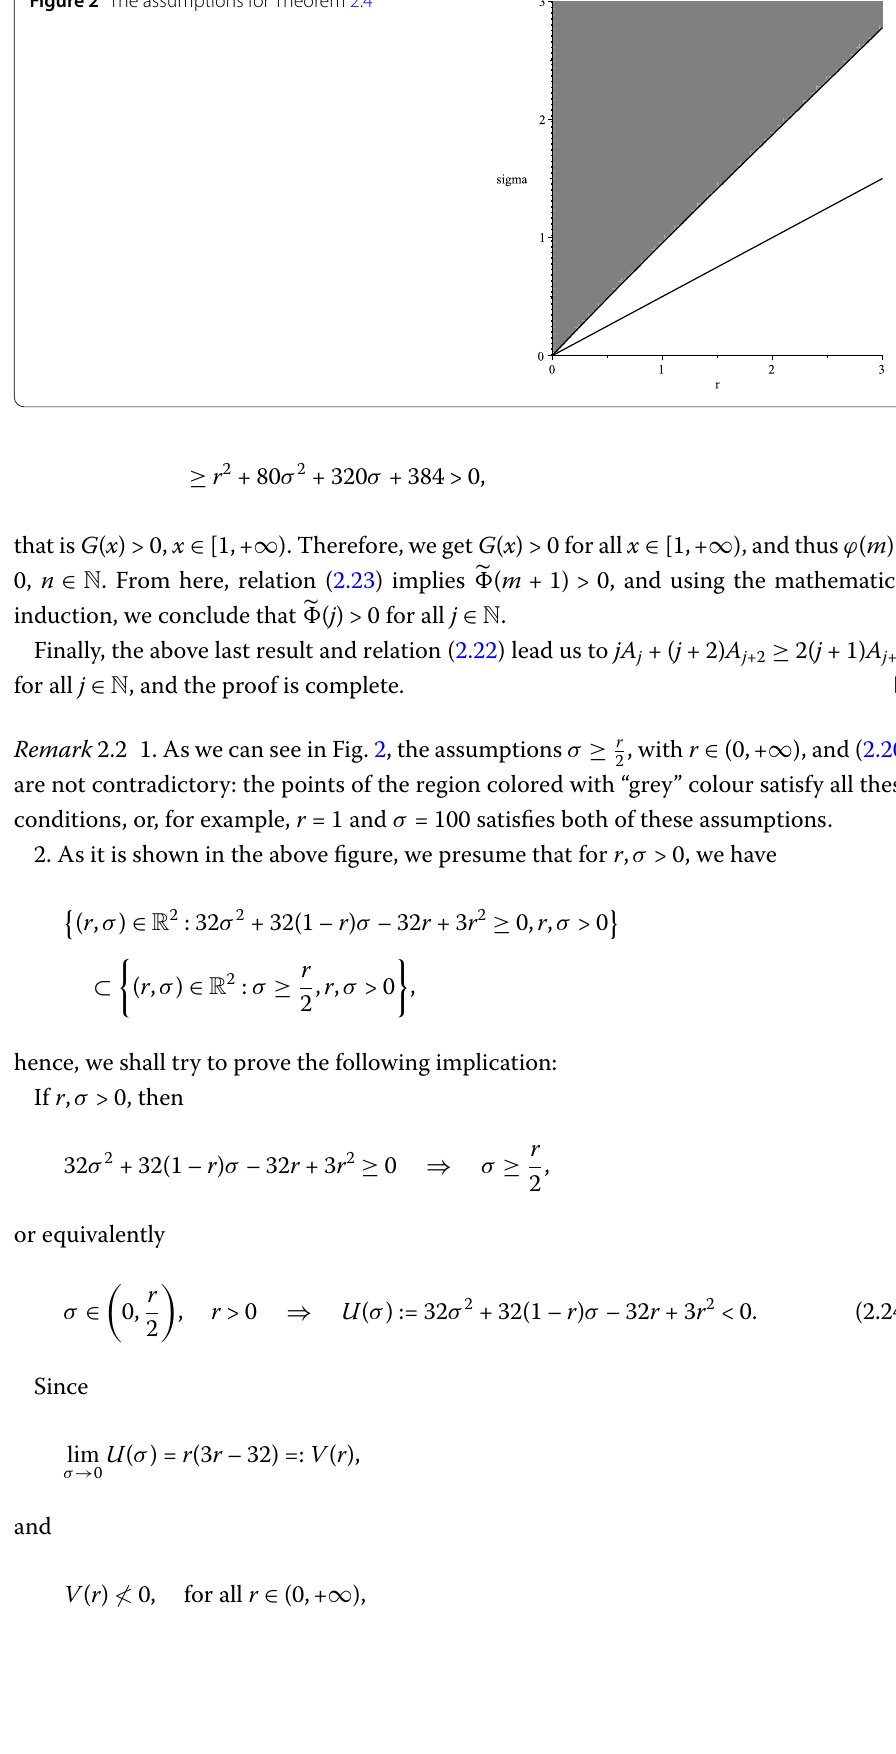
Figure 2 The assumptions for Theorem